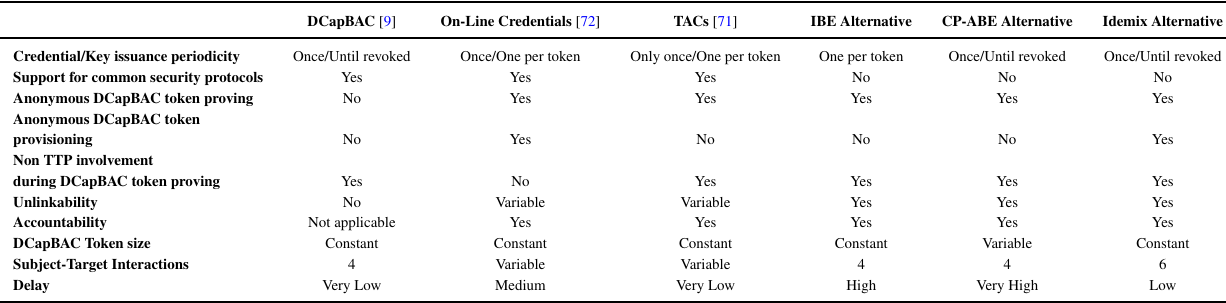
Table 1. Alternatives